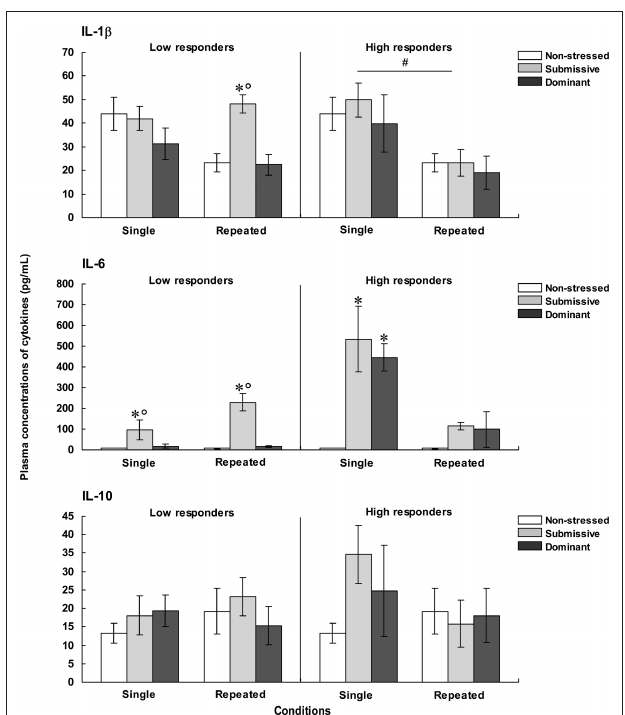
Figure 3 | Plasma concentrations (pg/ml) of iL-1 β (top), iL-6 (middle), and iL-10 (bottom) in non-stressed mice as well as in submissive and dominant mice engaged in one (single) or three (repeated) aggressive encounters. Data for low corticosterone responders are shown in the left panel, whereas data for high responders are depicted in the right panel. The N / group was the same as that described in Figure 1 . Data represents means ± SEM. * p < 0.05 relative to non-stressed mice. * ° p < 0.05 relative to non-stressed and dominant mice. # p < 0.05 relative to the single